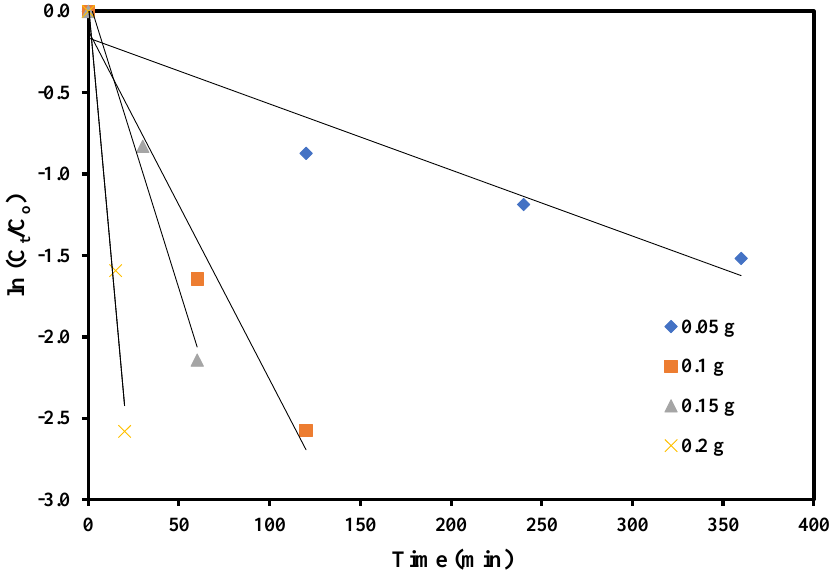
Figure 8. Rate constant values at different amounts of catalyst for the reduction of resorcinol using GO-Ag-ZnS nanocomposite as catalyst.